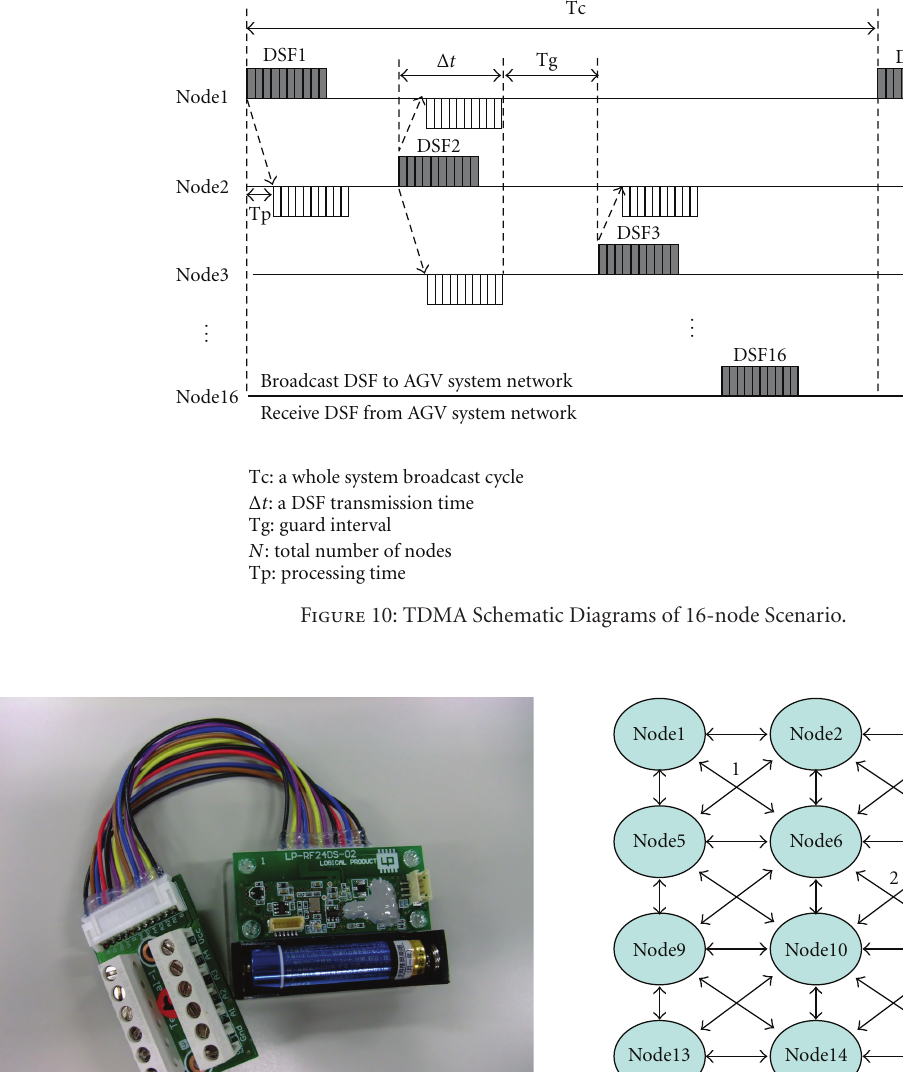
Figure 12: Topology A of 3-hop